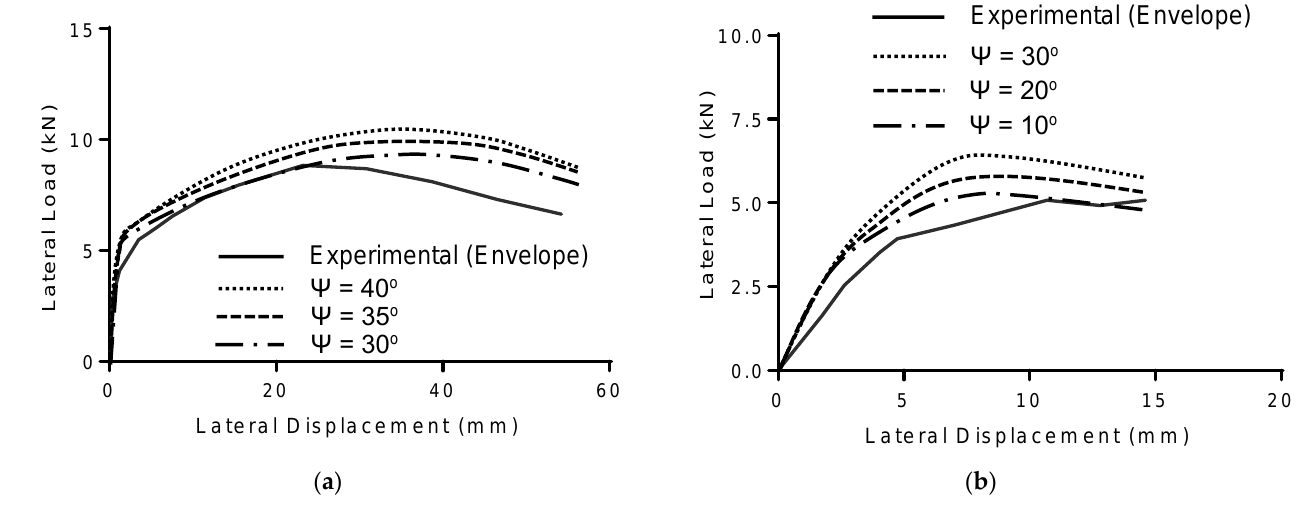
Figure 12. Load-displacement curves for sub-standard joints. ( a ) Joint J2 ( b ) Joint J4. The joint J1 ultimate carrying capacity is the highest one among the considered three reference joints, this is attributed to the presence of joint stirrups (ties). These ties increased the joint shear resistance and carried the tensile stresses as plotted in Figure 13. These stirrups enabled the beam longitudinal bars to reach their yield limit. Due to the absence of these ties in joints J2 and J4, rapid and concentrated damage was observed in the joint panel zone, as illustrated in Figure 14. This damage hindered the beam longitudinal bars to reach their yield limit. Inside the joint panel zone, the principale maximum tensile stress level observed in Figure 14 for joint J2 was greater than that reached in Figure 10 for joint J1.